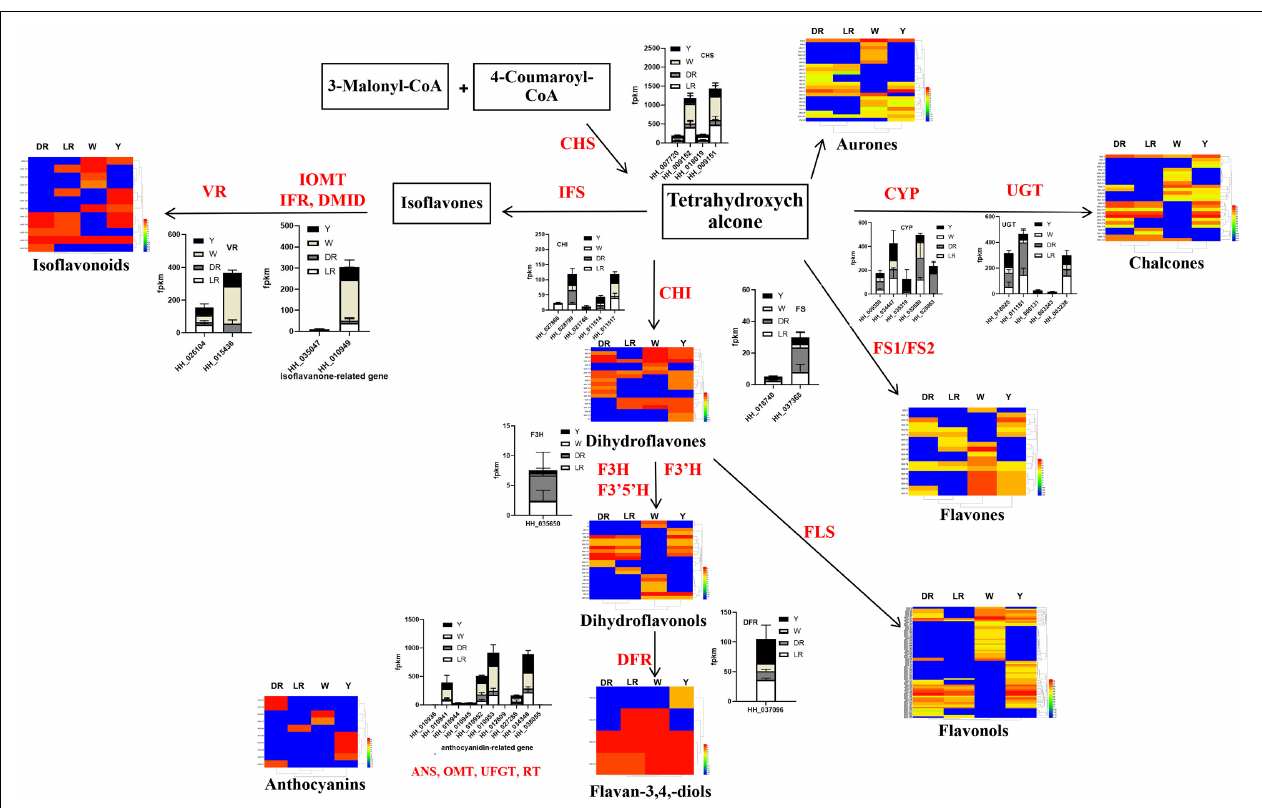
FIGURE 6 | Integrated analysis of the transcriptome and metabolome on the flavonoid biosynthesis pathway with different colors. The core schematic diagram of flavonoid synthesis in safflower was drawn based on our previous research reports (Chen et al., 2020) and the review of Winkel-Shirley (2002). Various flavonoid metabolic species detected in safflower and the annotated flavonoid biosynthesis genes and the candidate genes for biosynthesis of C-glucosylquinochalcones were shown in the figure. Gene expression was represented by stacked graphs and that the length of each bar shows the expression of each gene. DFR,